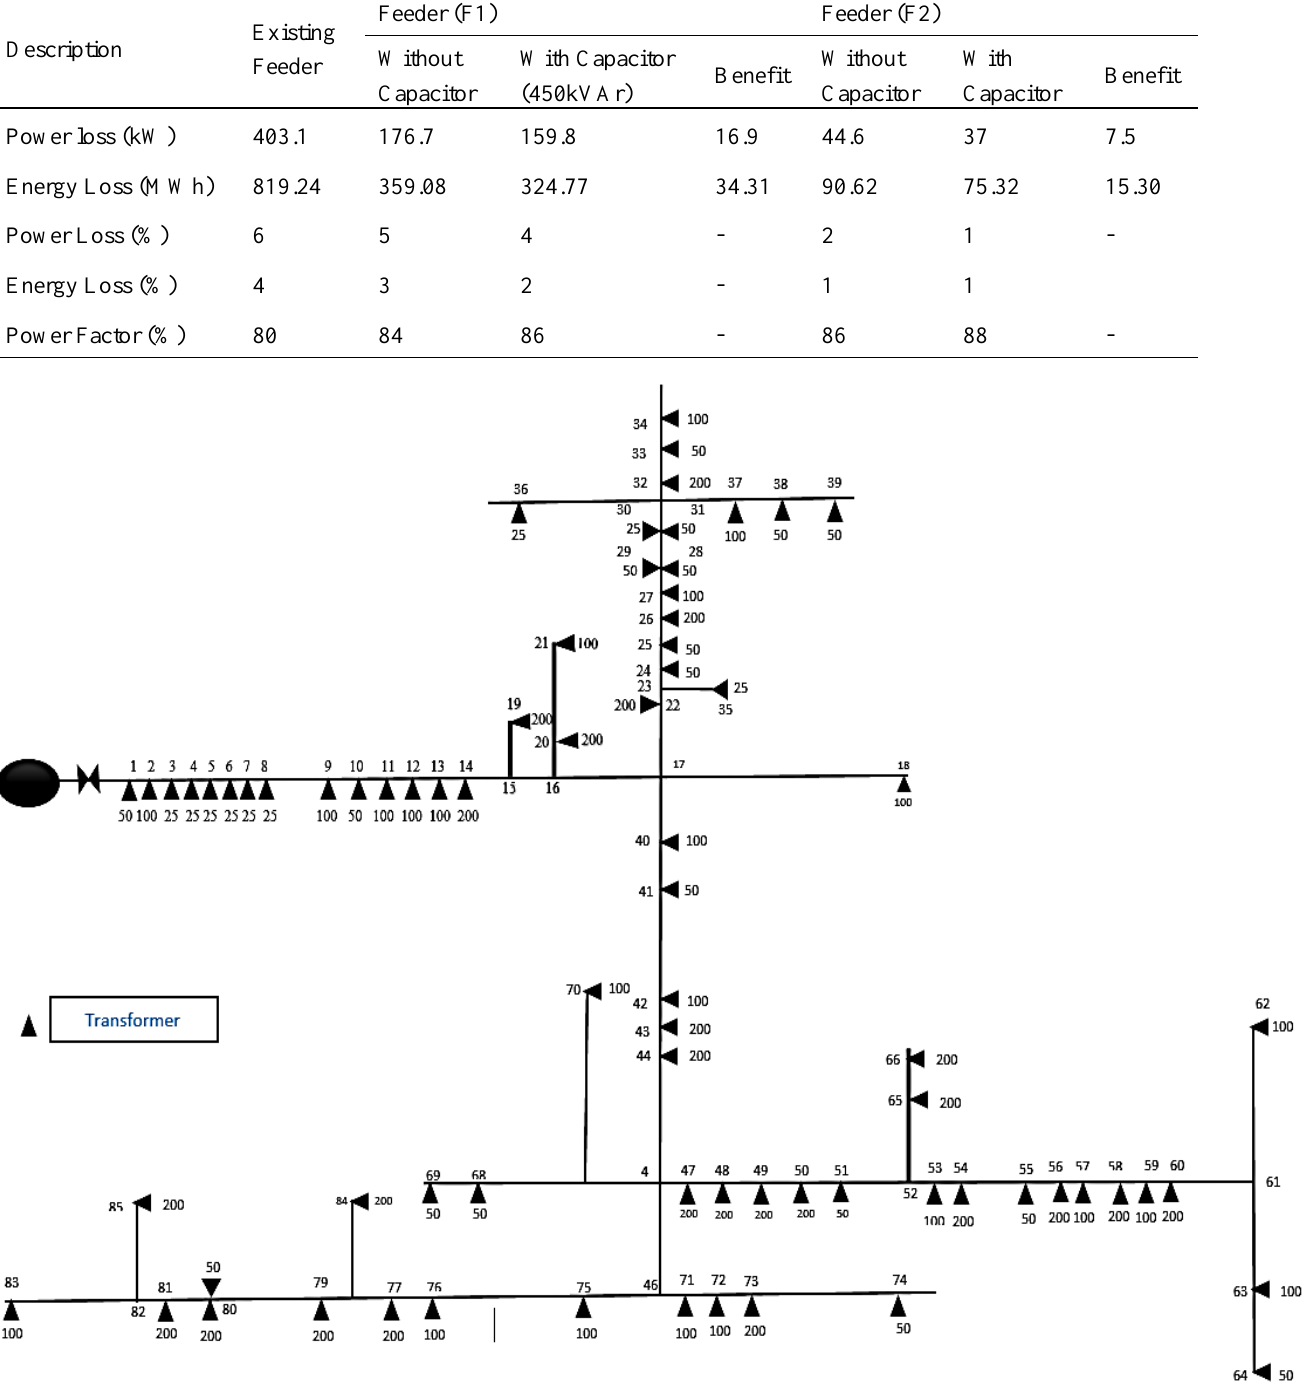
Fig. 3. Line diagram of the existing system (EidGah